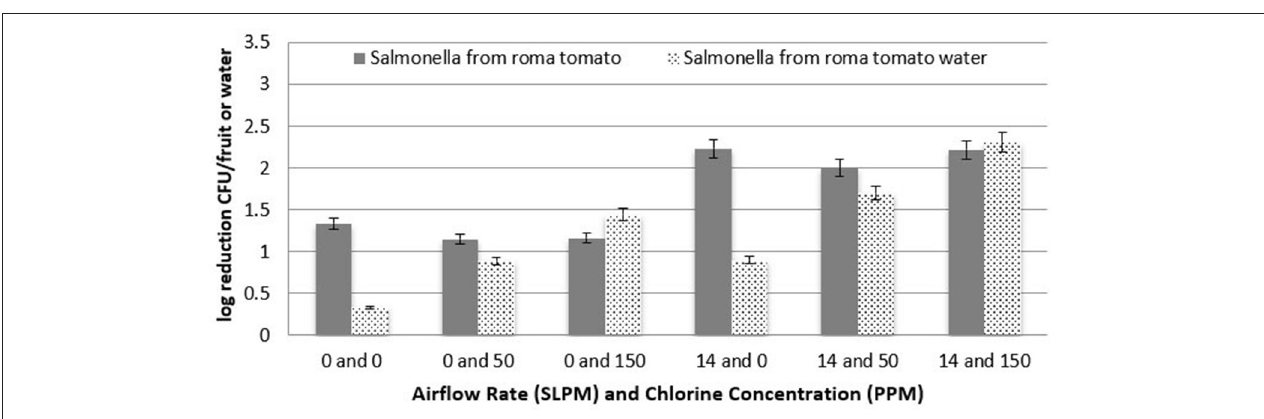
Frontiers in Sustainable Food Systems |